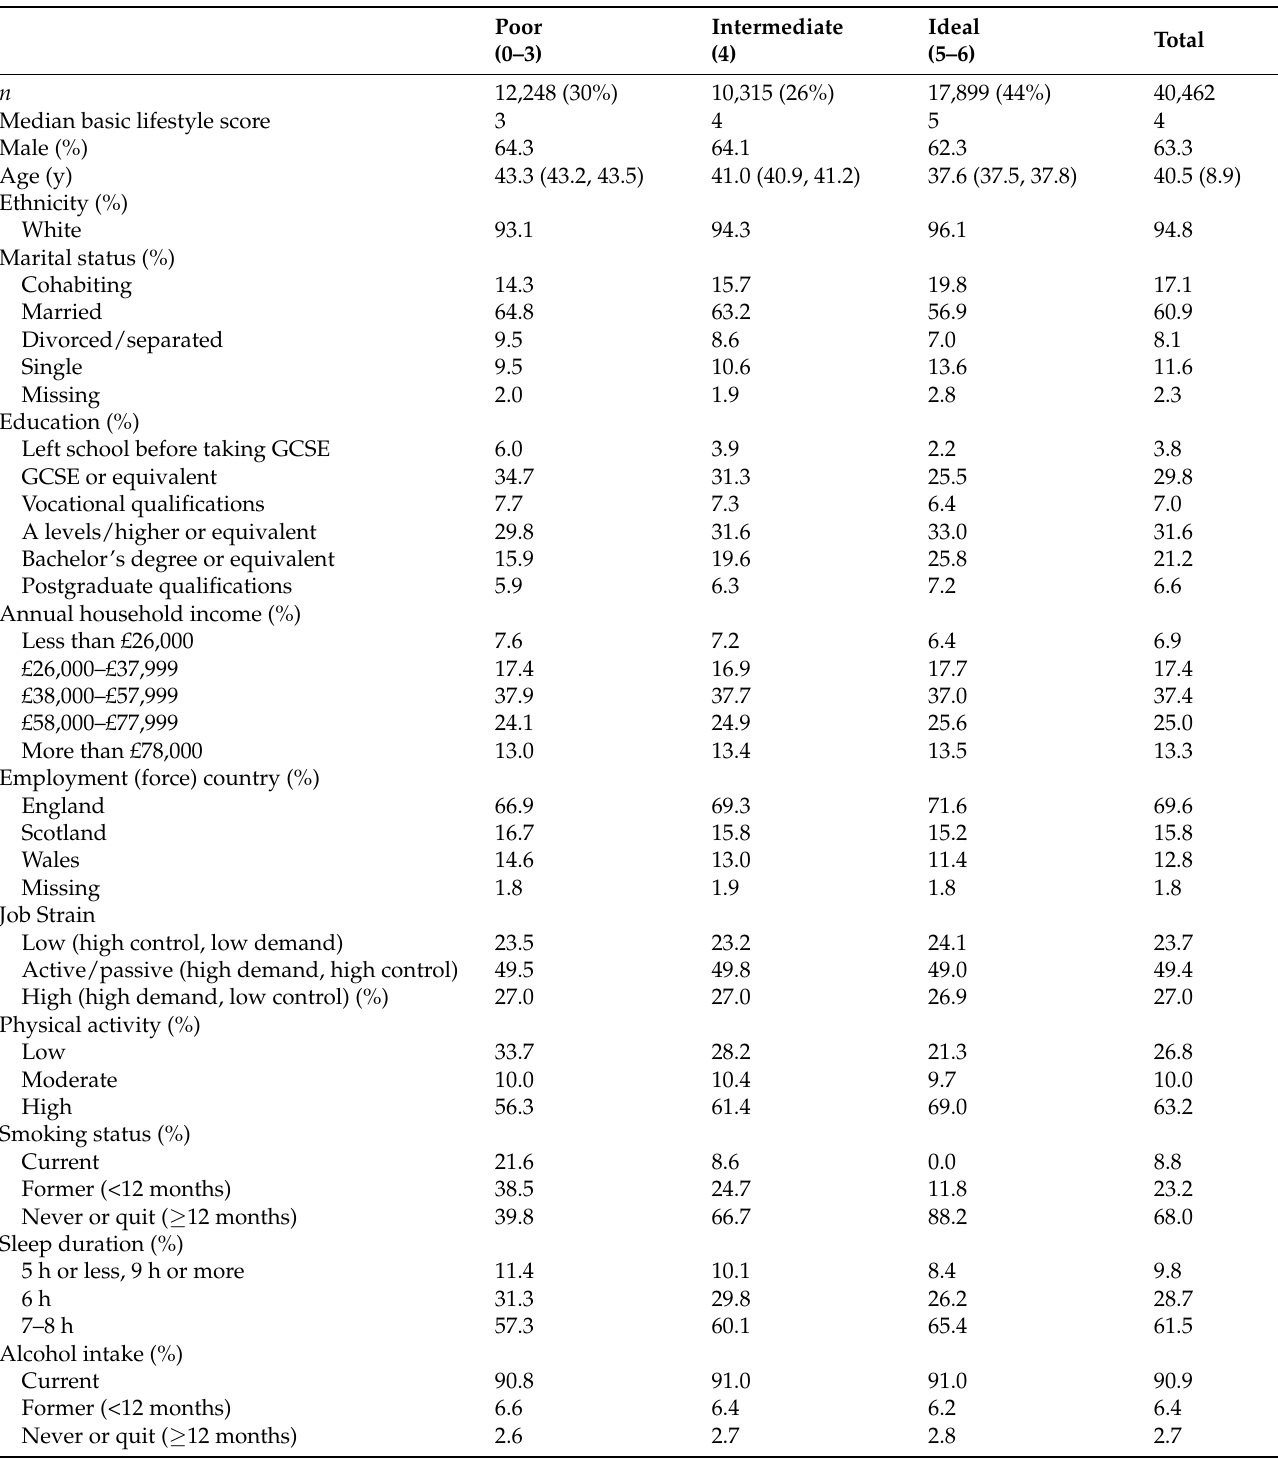
Table 2. Baseline characteristics stratified by poor, intermediate, and ideal basic lifestyle scores in 40,462 participants of the Airwave Health Monitoring Study a,b . Poor